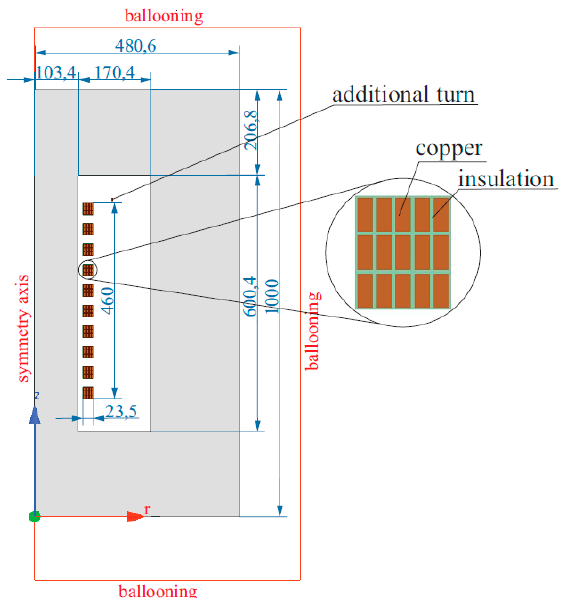
Figure 3. 2D FEM model of 450 turn LV winding.